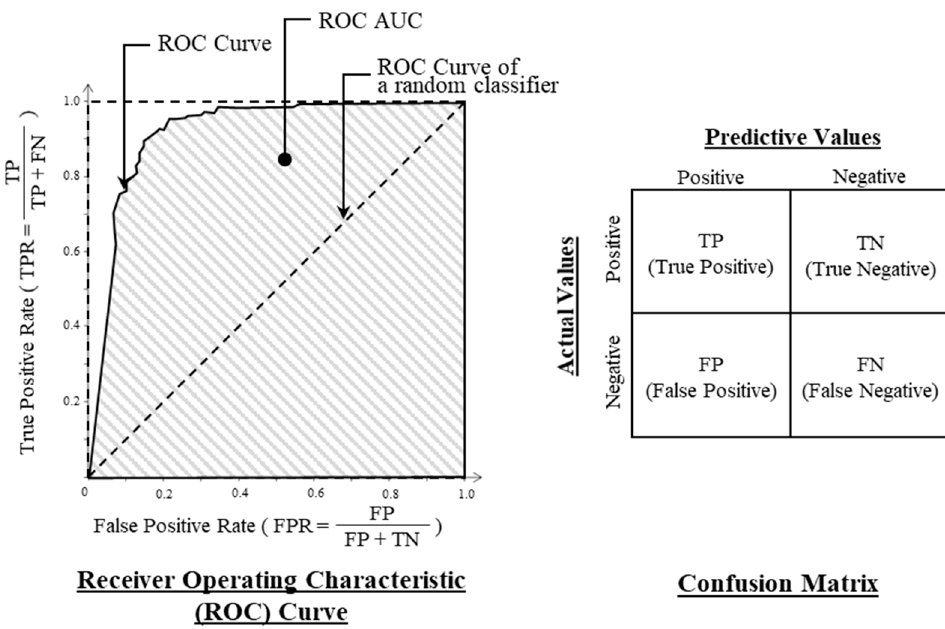
Figure 9. Definition of ROC AUC and Confusion Matrix.